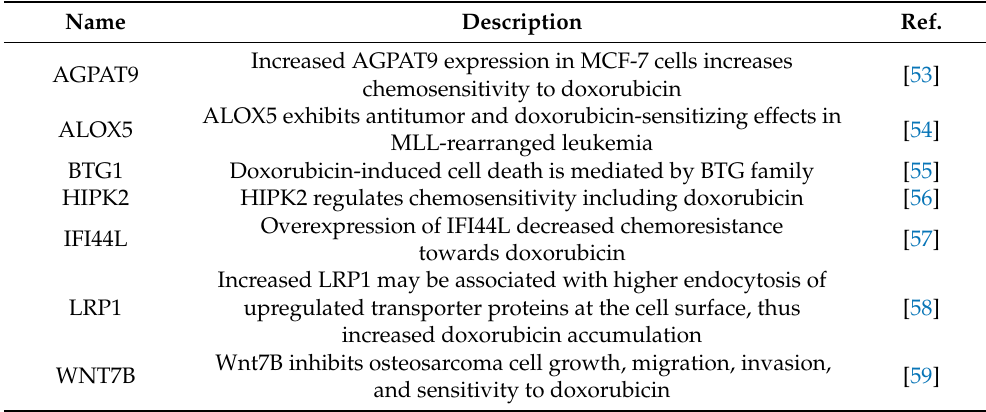
Table 3. List of genes reported to exhibit synergy with doxorubicin in either AML or other cancer cell